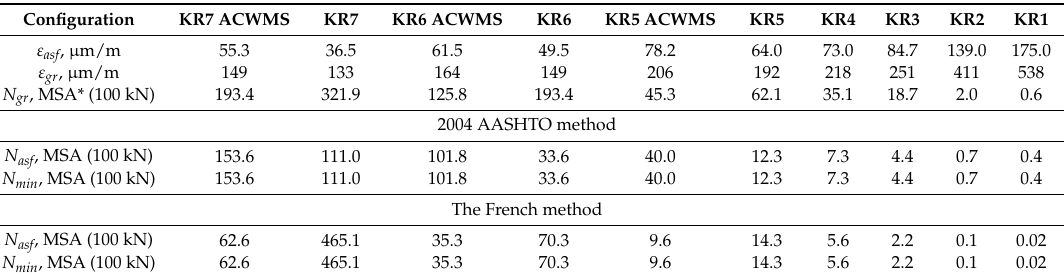
Table 4. The results of calculations of design life of the structures (stiffness of the asphalt layers according to